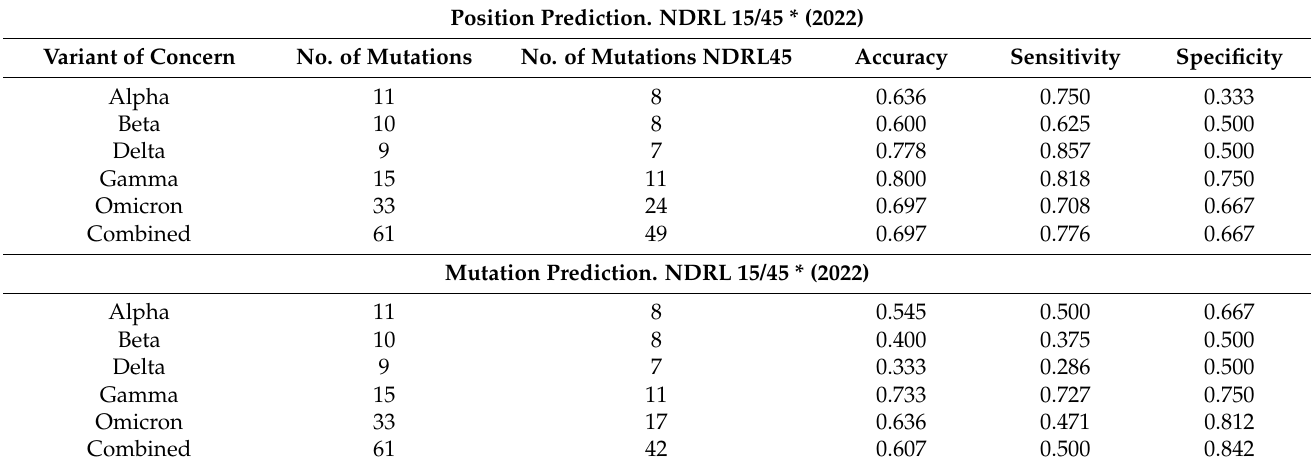
Table 2. Performance over variants of